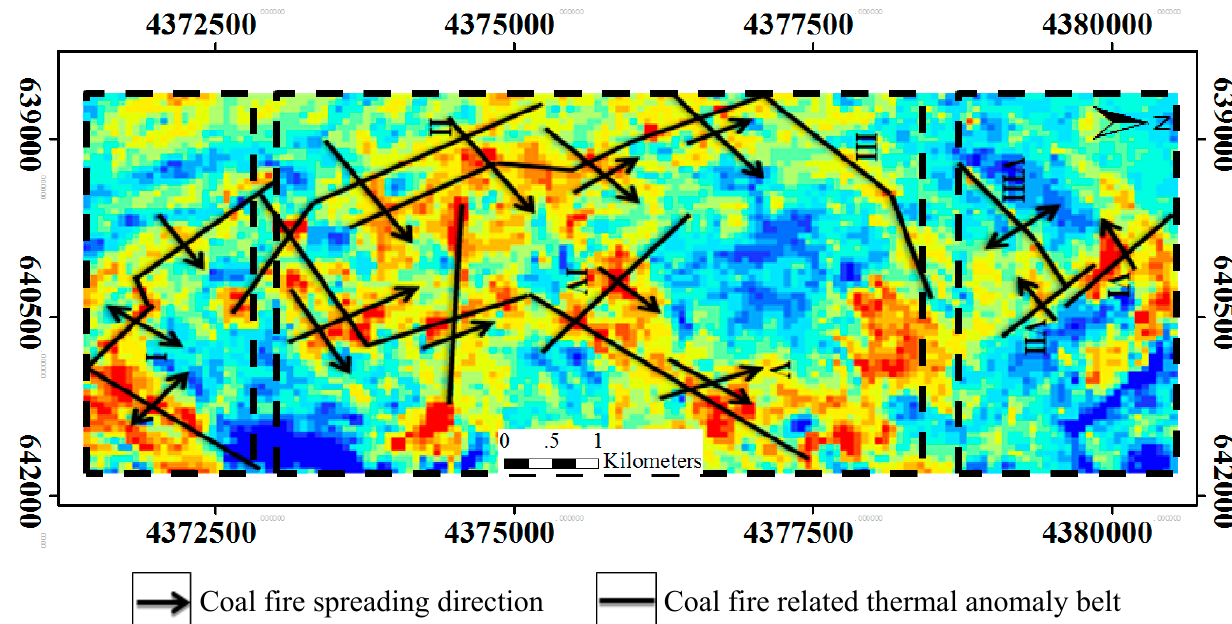
Figure 14. Four years’ worth of coal fires results were chosen from the time range 2000–2006. To show the coal fire spreading direction directly and simply using the GIS software ArcGIS and ENVI, the results of coal fires of 2000, 2002, 2004 and 2006 were stacked for the purpose of the overlay analysis, and the coal fire spreading directions were also delineated in this image with the 1999 ETM+ TIR band 6 data as the base map.